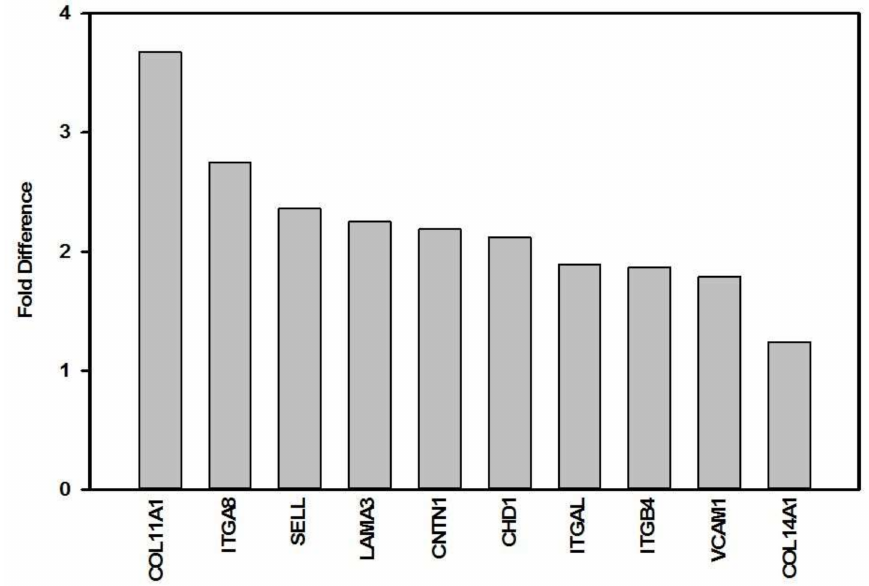
Figure 2. Significant up-regulation (fold difference >1) of genes related to CAMs in diabetic wounded cells irradiated with 660 nm at 5 J/cm 2